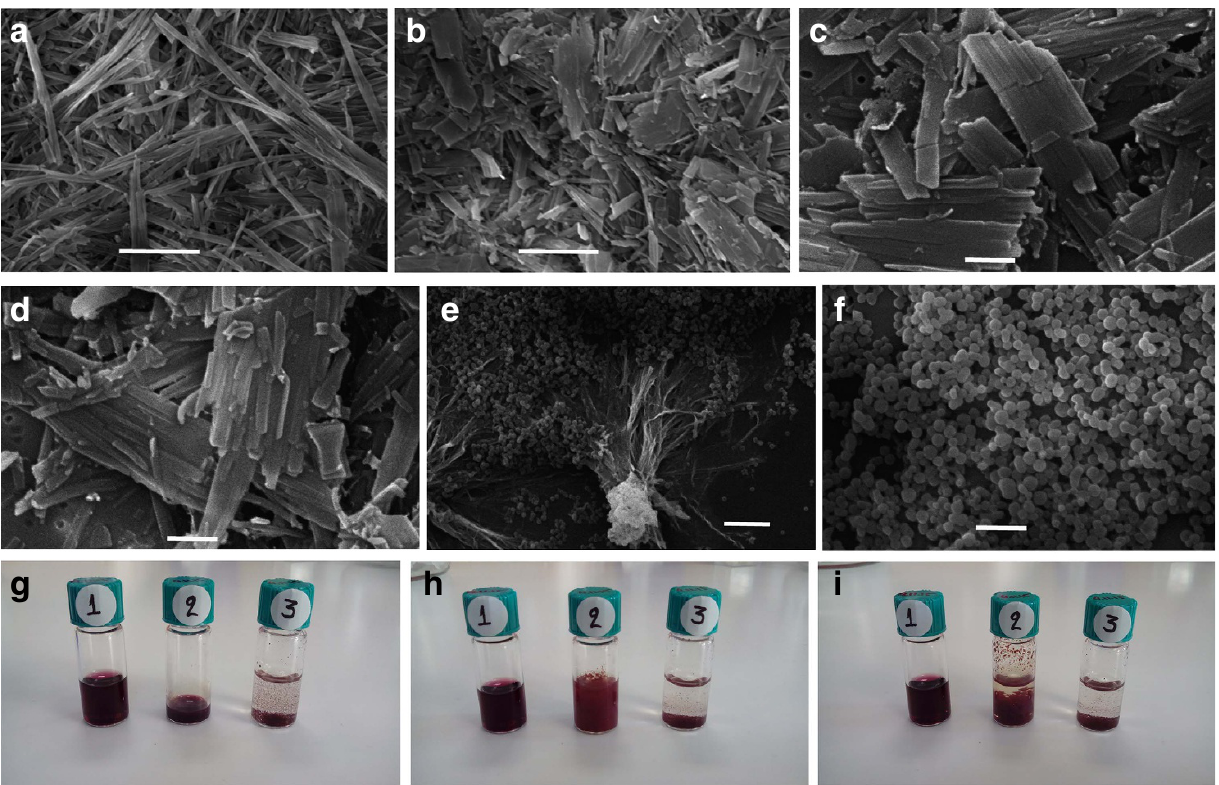
Figure 2 | Changes in the morphology of Fmoc-F L F L -TPP with the solvent composition. Samples observed in SEM following critical point drying of Fmoc- F L F L -TPP dissolved in dry dichloromethane which was injected into n- heptane at room temperature. Final relative ratios (v/v) of CH 2 Cl 2 to n- heptane